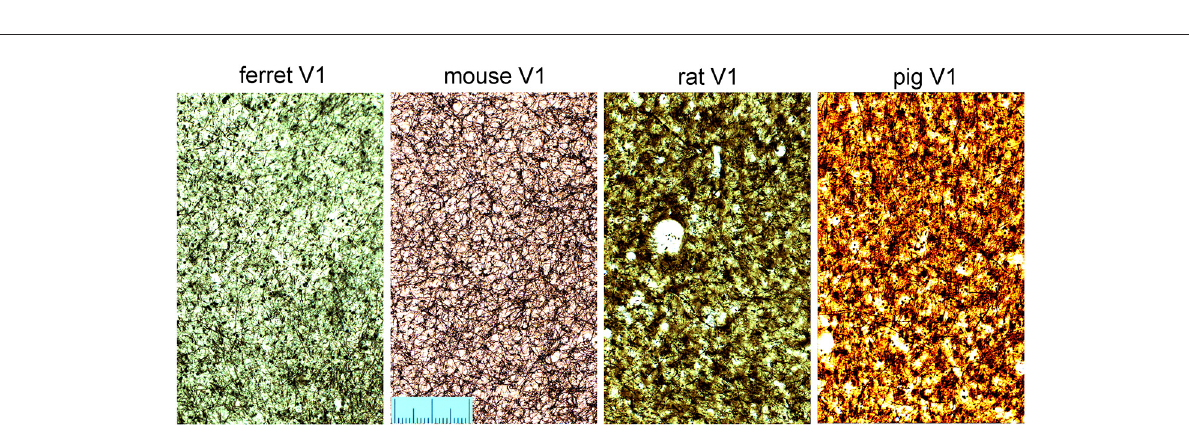
FIGURE8 Tangential sections through layer V of the primary visual area (V1) stained for myelin to show the pattern of myelinated fibers in four other mammalian species. The scale is 200 µ m